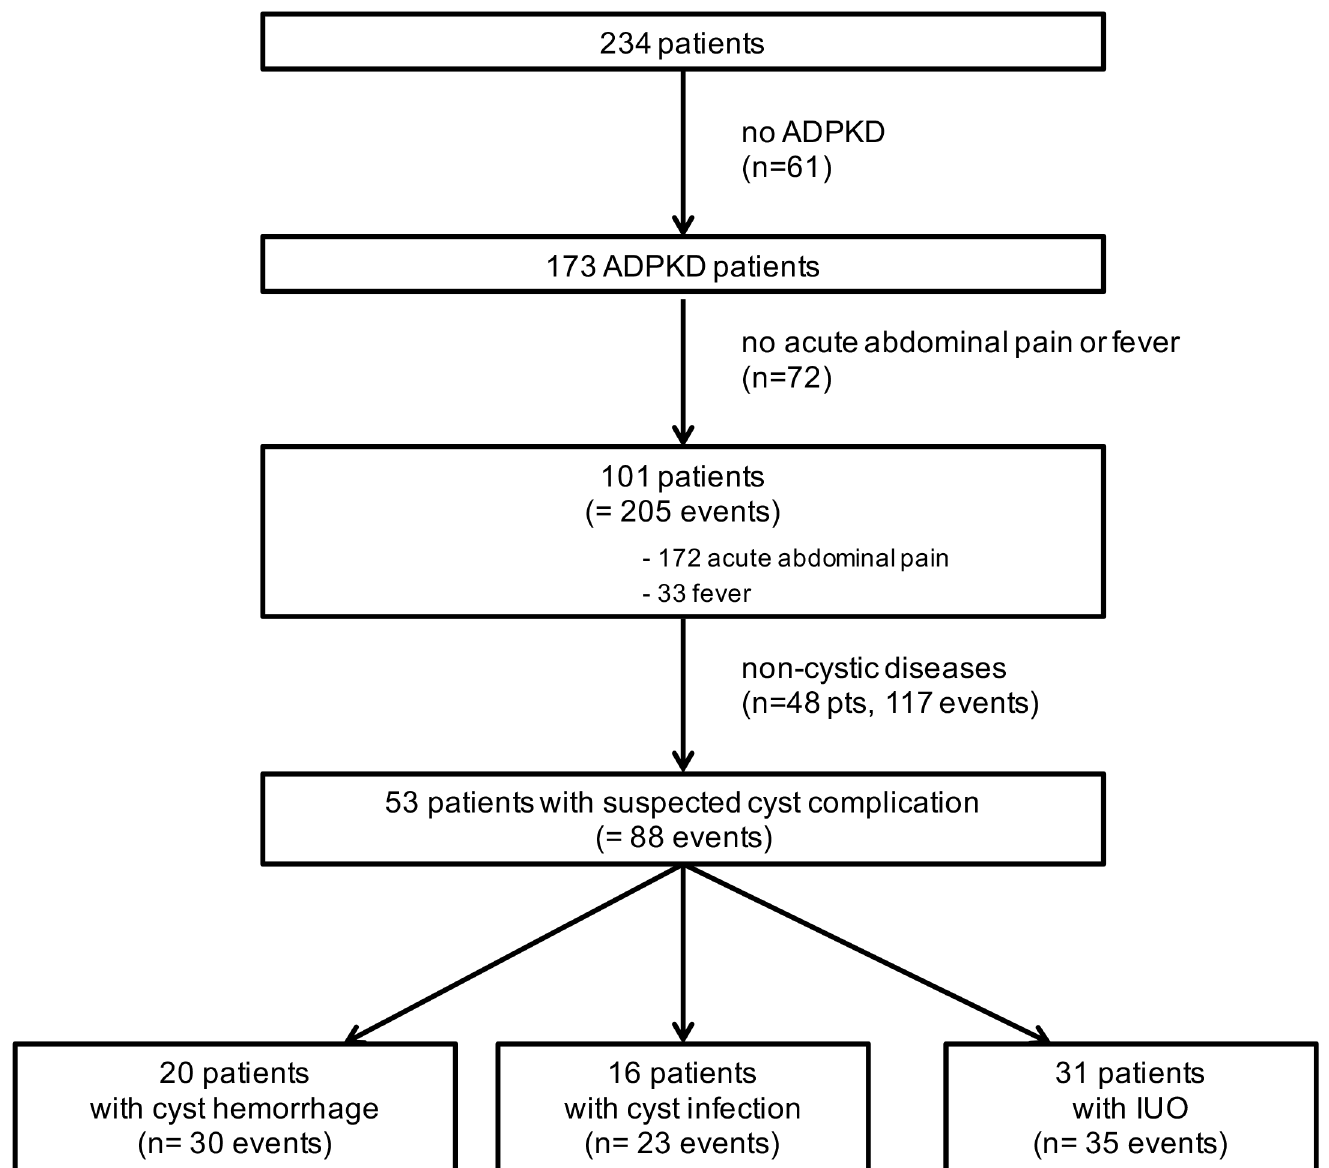
Fig 1. Selection process of patients with autosomal dominant polycystic kidney disease (ADPKD) presenting with suspected acute cyst complication. One given patient may present with different types of cyst complications